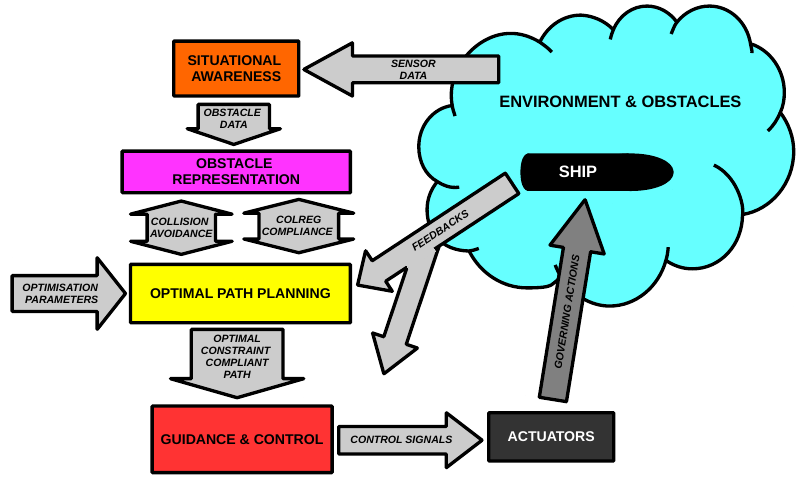
Figure 1. The guidance navigation and control architecture object of this